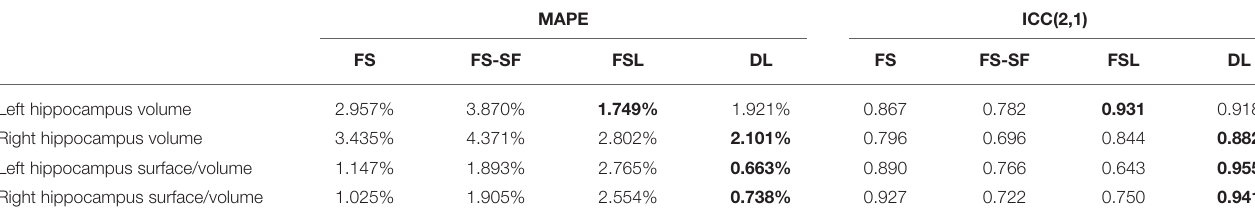
TABLE 2 | Robustness in terms of mean absolute percentage error (MAPE) and intraclass correlation coefficient